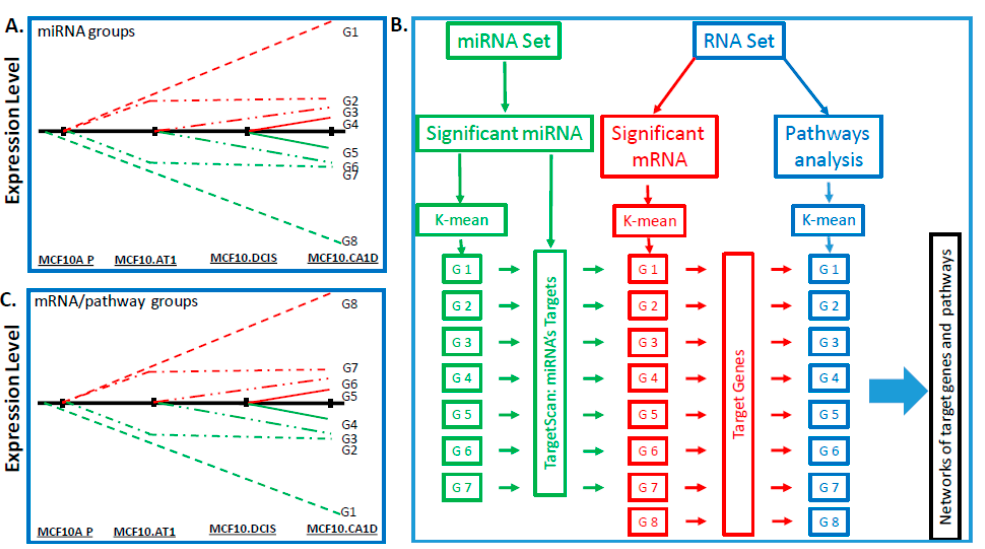
Figure 1. Bioinformatics pipeline. Schematics showing eight patterns of interest (including early changes, early sustained changes, and late changes) that were used as criteria for identifying meaningful changes in ( A ) miRNAs and in ( C ) mRNAs and pathways that define breast cancer progression across a panel of cell lines comprising normal-like (MCF10A.P), preneoplastic (MCF10.AT1), DCIS (MCF10.DCIS), and invasive cancer (MCF10.CA1D) cells. The red lines (Figure 1A and 1C) indicate that miRNA/mRNA expression levels and pathway scores are higher in progressive stages and the green lines indicate that miRNA/mRNA expression levels and pathway scores are lower in progressive stages compared to MCF10A.P. ( B ) Flowchart showing the bioinformatics pipeline for processing of miRNA- and RNA-sequencing datasets to derive target genes and pathways. First, statistical significance analysis (as described in Methods) was used to identify meaningful miRNAs and RNAs across the breast cancer progression steps, and parametric analysis of gene set enrichment (PAGE) was used to calculate scores of the pathways. Then, a k-mean clustering analysis was used to group the significant miRNAs, RNAs, or pathways for the patterns of interest. TargetScan was applied to determine miRNAs’ targets, which were used to determine the target pathways, if the target genes are among the pathway gene membership. At the last, networks were drawn to visualize the relationships between miRNA, target genes, and pathways. None of the miRNA conforming to the expression pattern of G8 were identified, therefore G8 is missing in the miRNA